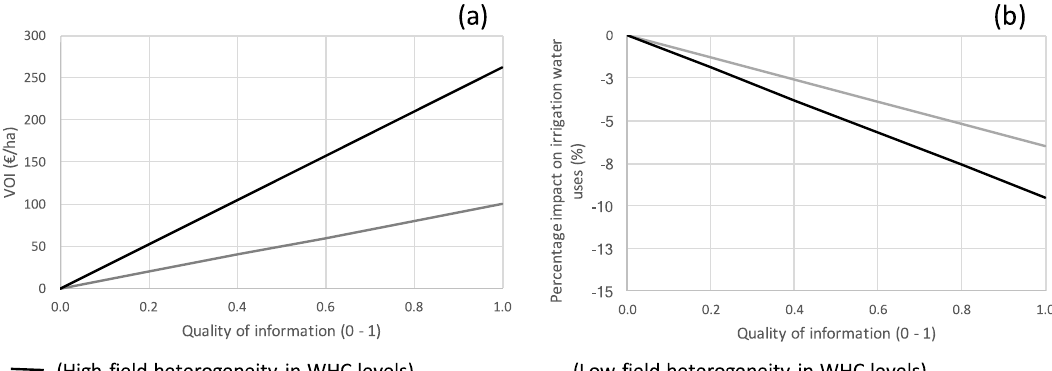
Figure 1. VOI ( a ); and percentage variation in water uses ( b ) generated with the transition to PI for increasing differences of the quality of the information obtained through the comparing information sources (0—no difference between the comparing information sources; 1—maximum difference between the comparing information sources): example given for processing tomatoes cultivated on soils with high and low soil WHC levels.